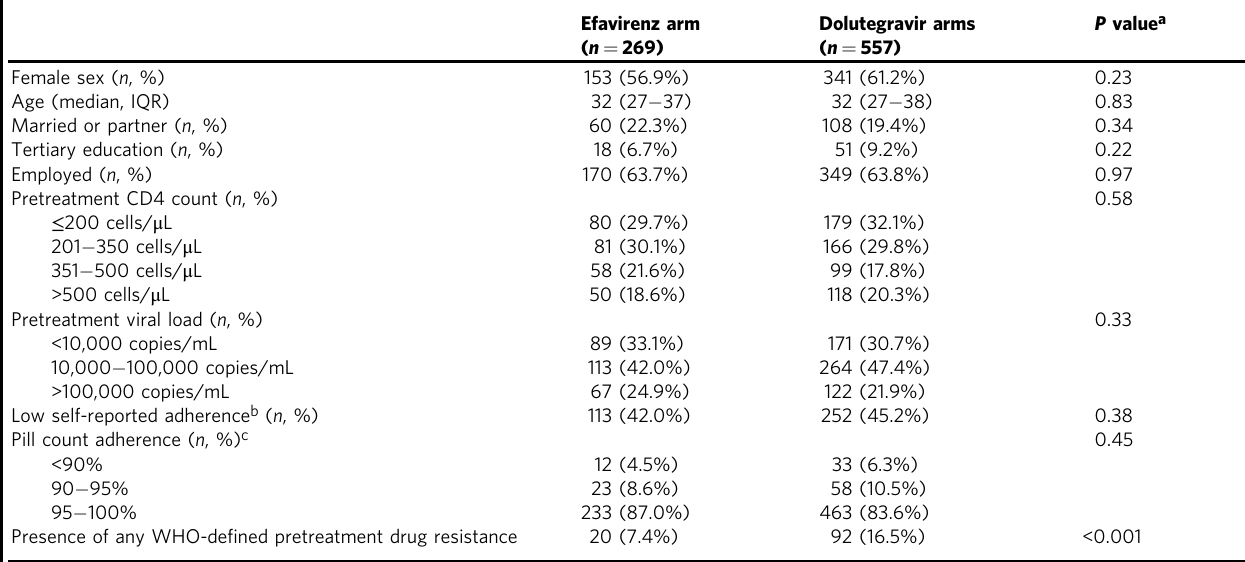
Table 1 Cohort characteristics for participants who completed pretreatment HIV drug resistance testing and included in our primary analysis of virologic failure, divided by regimen.